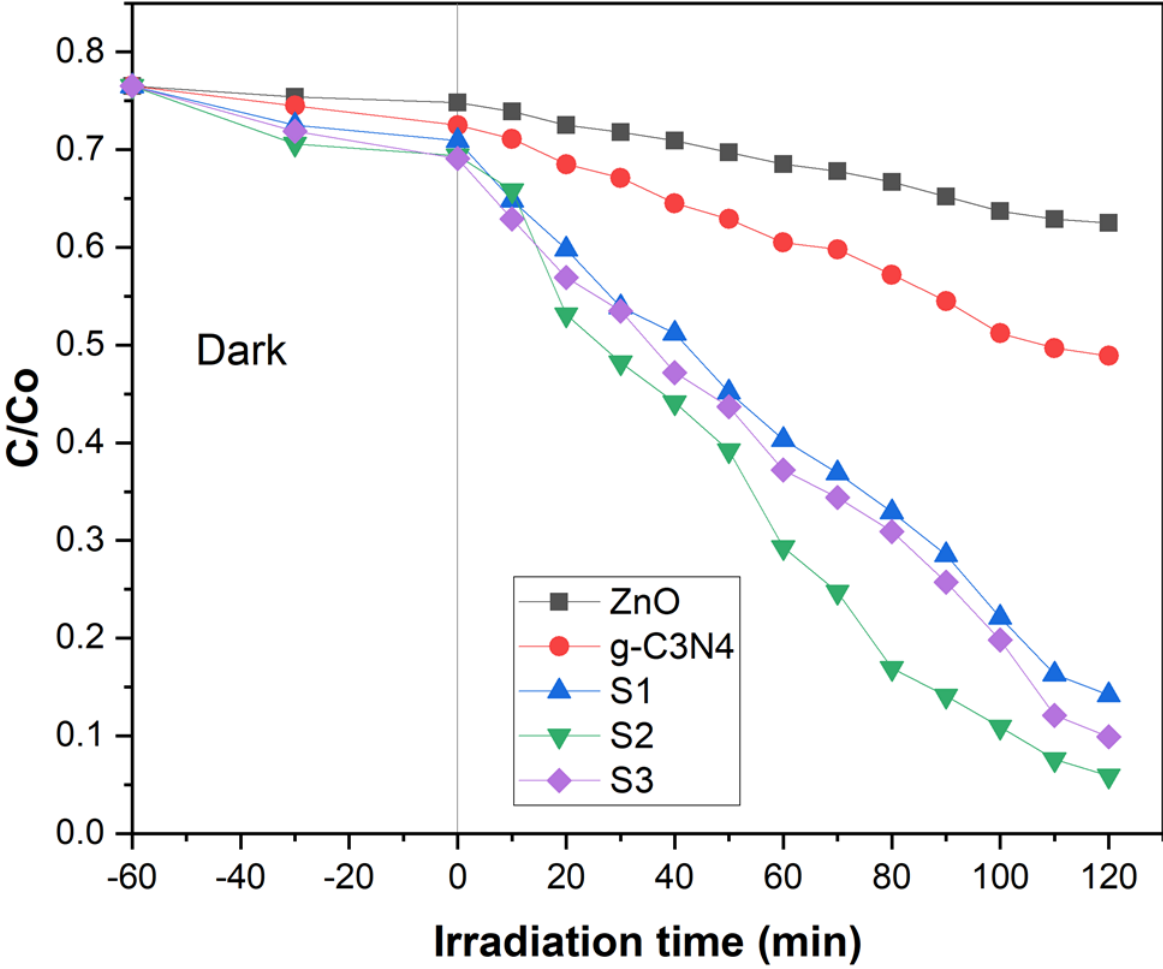
Figure 4. Photo-catalysis of ZnO, g-C 3 N 4 , and S1, S2, and S3 POA/g-C 3 N 4 /ZnO composites on Congo red dye.